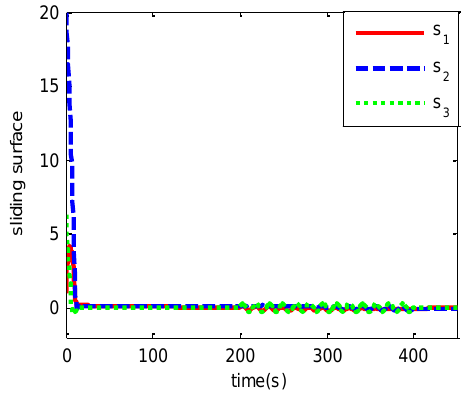
Figure 5. Sliding surfaces of the proposed controller.